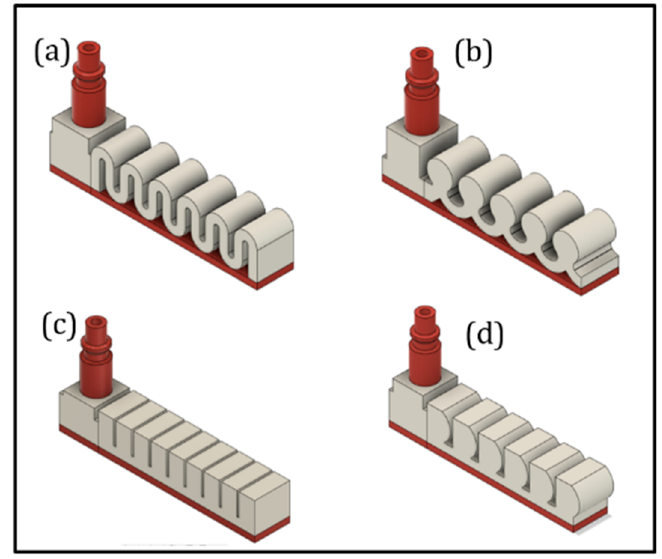
Figure 8. MBP shapes: ( a ) S-type, ( b ) B-type, ( c ) R-type, and ( d ) D-type.